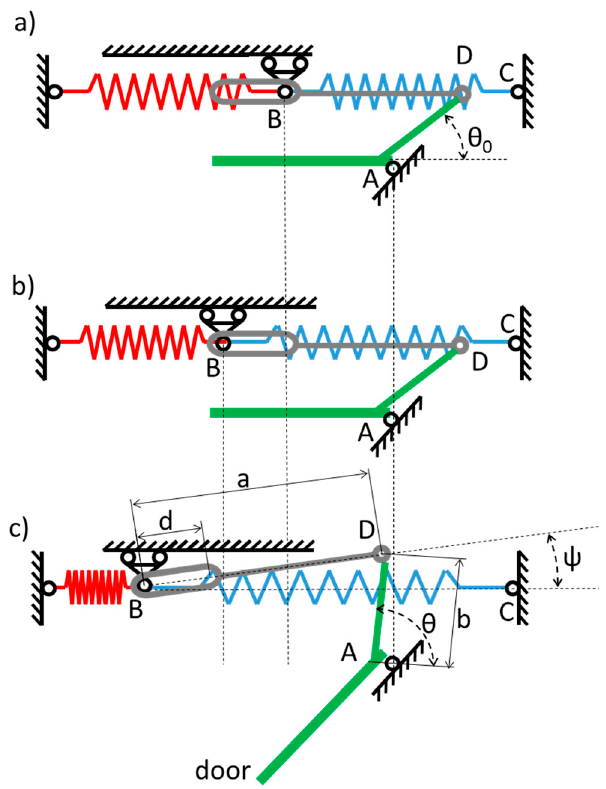
Figure 7. Schematic layout of the proposed device: initial state of the system ( a ); leftward translation of the point B due to the spring activation ( b ); rotation of the door ( c ).